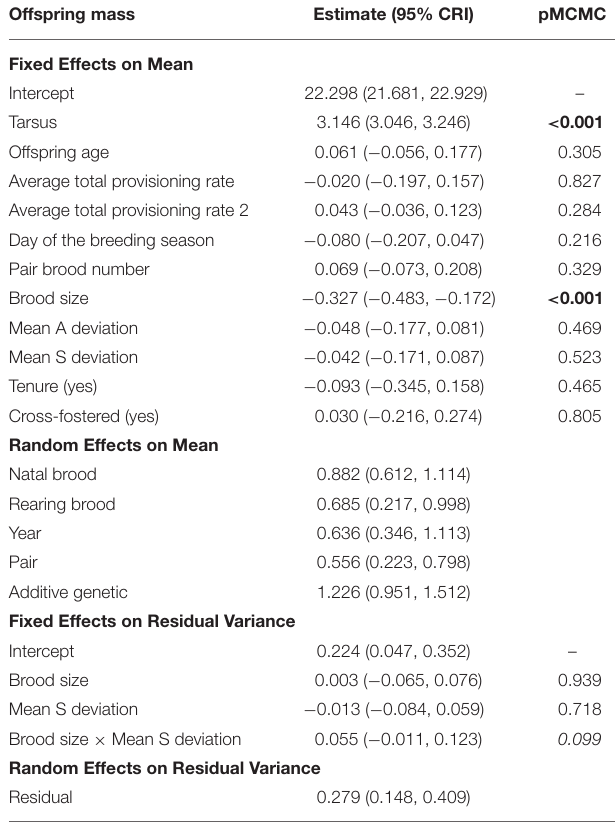
TABLE 2 | Model estimates and 95% credible intervals (CRI) for each of the predictors of offspring body condition ( N = 2,098 offspring that were measured around 12 days